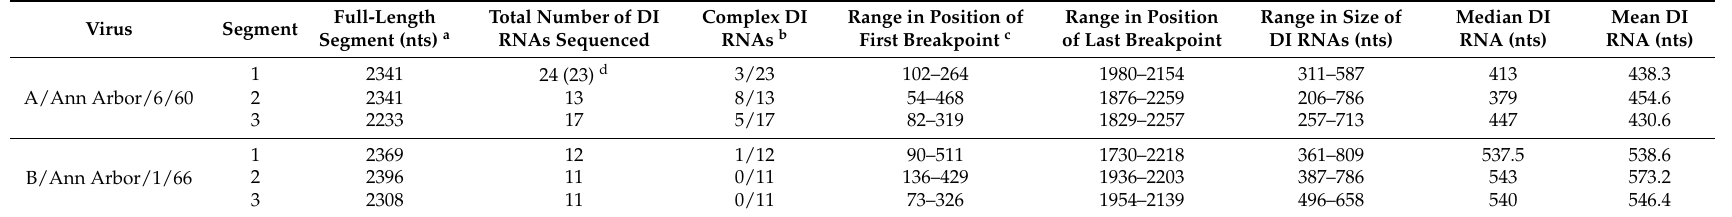
Table 1. Summary of DI RNA sequences isolated directly from Fluenz™ Tetra